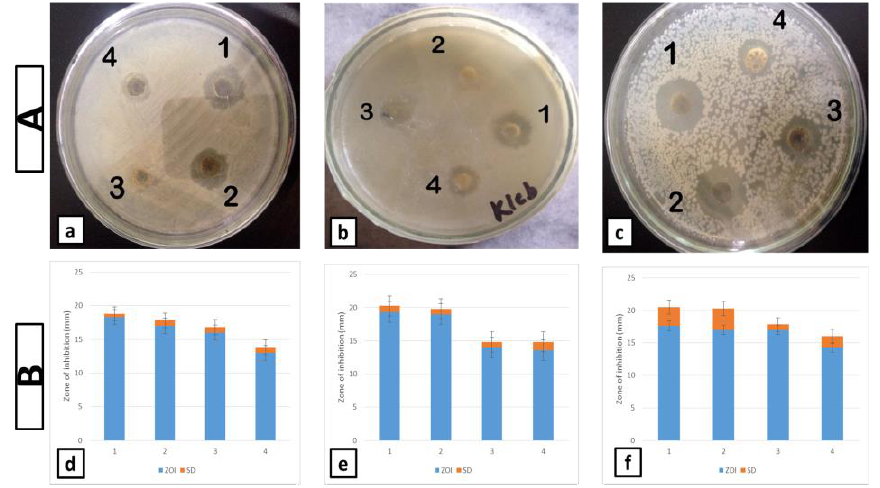
Figure 3. The marketed creams were ‘Quench’ cream (local brand) and ‘Dermazin’, a multinational cream, in order to determine whether the antibacterial activity is comparable to commercialized creams. For that purpose, a statistical comparison was carried out by applying ANOVA and LSD. The one-way ANOVA is used to determine whether there are any significant differences between the means of three or more independent (unrelated) groups. The result of the test showed p -values of 0.001, 0.018, and 0.280 for E. coli , K. pneumoniae , and S. aureus , respectively. The results of the one-way ANOVA indicate the overall difference between the groups (the p -value obtained for the Gram-negative strain); E. coli was 0.001, which indicates that a significant difference exists in the antimicrobial activity of the three formulations (i.e., nanolotion, Quench, and Dermazin), whereas the p -value obtained for K. pneumoniae (the Gram-negative strain) was 0.018, which indicates a significant difference in the antibacterial activity of three formulations. However, the p -value for the Gram-positive strain S. aureus came out to be 0.280, which indicates that no significant differences exist between the antibacterial activity of the three formulations, i.e., they have comparable antibacterial activity against the S. aureus . One-way ANOVA is an omnibus test statistic and cannot tell which specific groups were significantly different from each other (whether it is nanolotion and Quench, nanolotion and Dermazin, or Quench and Dermazin). To determine which specific groups differed from each other, post hoc test LSD was applied using SPSS, in which pairwise comparison of groups was carried out. Post hoc test LSD was then applied; in the case of E. coli , the p -value obtained for nanolotion and Quench was 0.018, for nanolotion and Dermazin it was 0.001, and for Quench and Dermazin the p -value came out to be 0.006, which indicates significant differences between nanolotion and Quench, nanolotion and Dermazin, and Quench and Dermazin, respectively. ZOI values as well as p -values indicate that the nanolotion has a superior antibacterial activity against E. coli as compared to the commercialized creams, i.e., Quench and Dermazin.